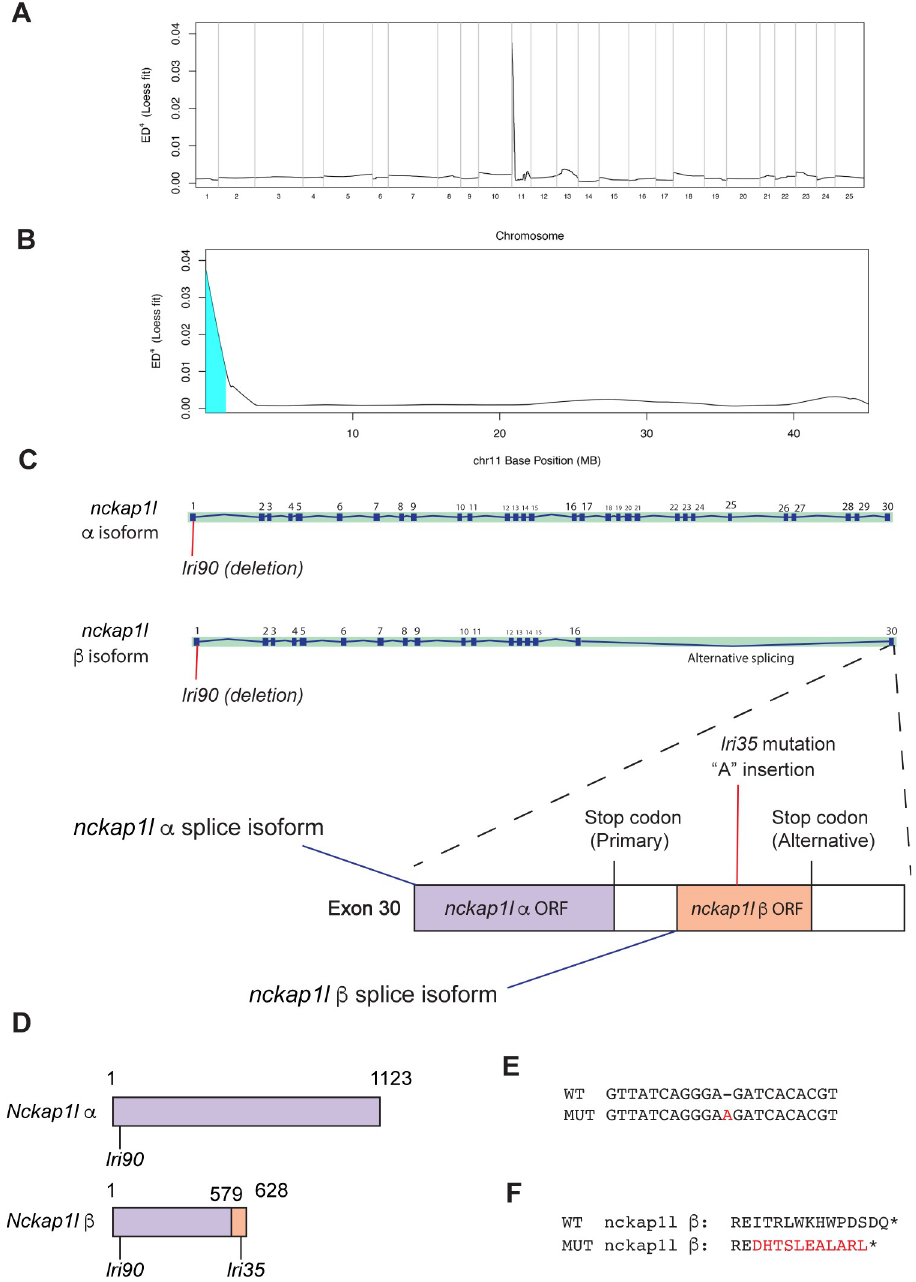
Fig 2. The lri35 mutation disrupts the minor isoform of the nckap1l gene. (A) Mapping of the lri35 mutation. Whole genome-wide Loess fit curve for SNP allele frequency Euclidean distance computed by the MMAPPR algorithm. Chromosome 11 showed the highest score. (B) Loess fit curve for SNP allele frequency Euclidean distance within chromosome 11. The critical region was mapped to the distal tip of chromosome 11. (C) The nckap1l gene has two splice isoforms: the previously annotated major splice isoform ( α isoform) and an unknown minor isoform (ß isoform). The lri35 mutation, which is a one-nucleotide insertion, is located in the last exon and induces a frameshift only in the ß isoform of the nckap1l gene. These data indicate that the minor isoform of the nckap1l gene is responsible for the phenotypes in lri35 mutant larvae. (D) Schematic of Nckap1l α and ß proteins. The entire Nckap1l α protein is recognized as the Nckap1l domain (purple box). Due to the alternative splicing of the nckap1l gene, Nckap1l ß shifted to the ß specific sequence (orange box) after the position 579. The lri90 mutation affects both Nckap1l α and ß, whereas the lri35 mutation affects Nckap1l ß only. (E) The lri35 mutation is an insertion mutation that inserts an additional adenine nucleotide into the nckap1l gene. (F) The lri35 mutation induces a frameshift and changes the last 13 amino acids of the ß isoform of the Nckap1l